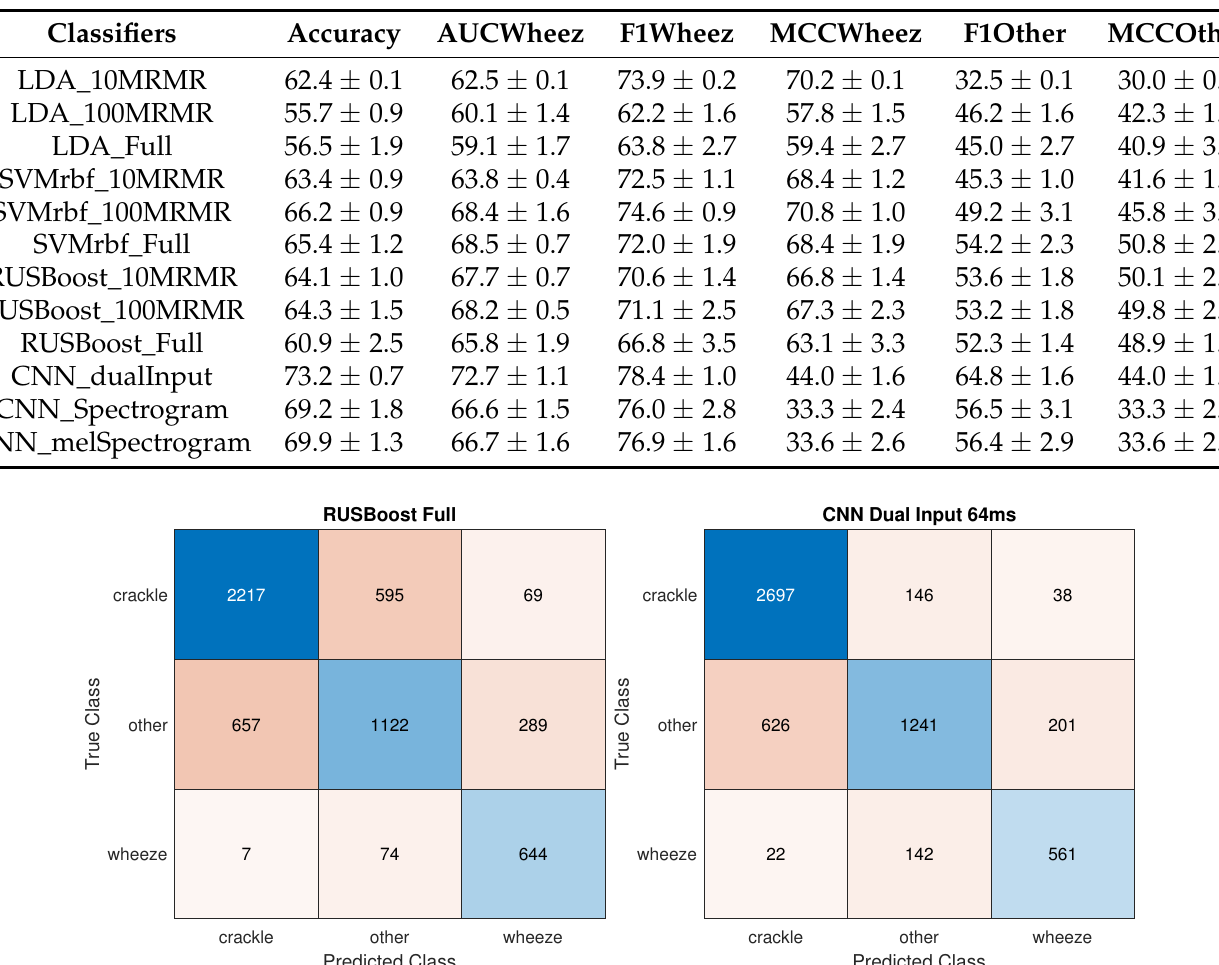
Table 16. Performance results obtained with 2 classes (wheeze vs. other)—training: variable duration; testing: variable duration.